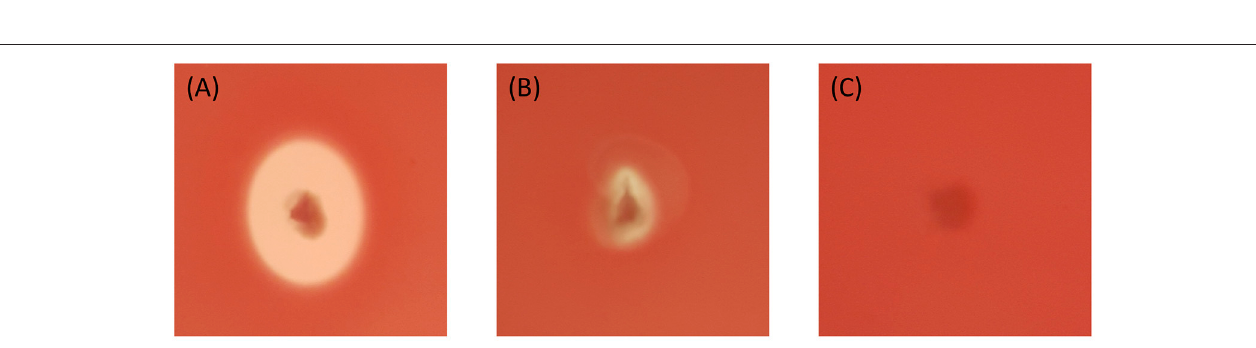
FIGURE 3 | Electrophoresis gel showing seven different plasmid patterns observed among the Bt collection (1–7). L represents a 1kb plus ladder; H14 is the reference strain Bacillus thuringiensis israelensis , HD1 is the reference strain Bacillus thuringiensis kurstaki ; 1, QBT229; 2, QBT6; 3, QBT43; 4, QBT212; 5, QBT99; 6, QBT3; 7, QBT375.